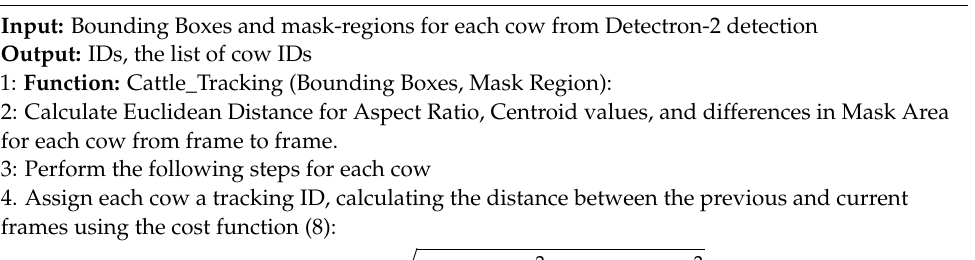
Algorithm 1. Cattle